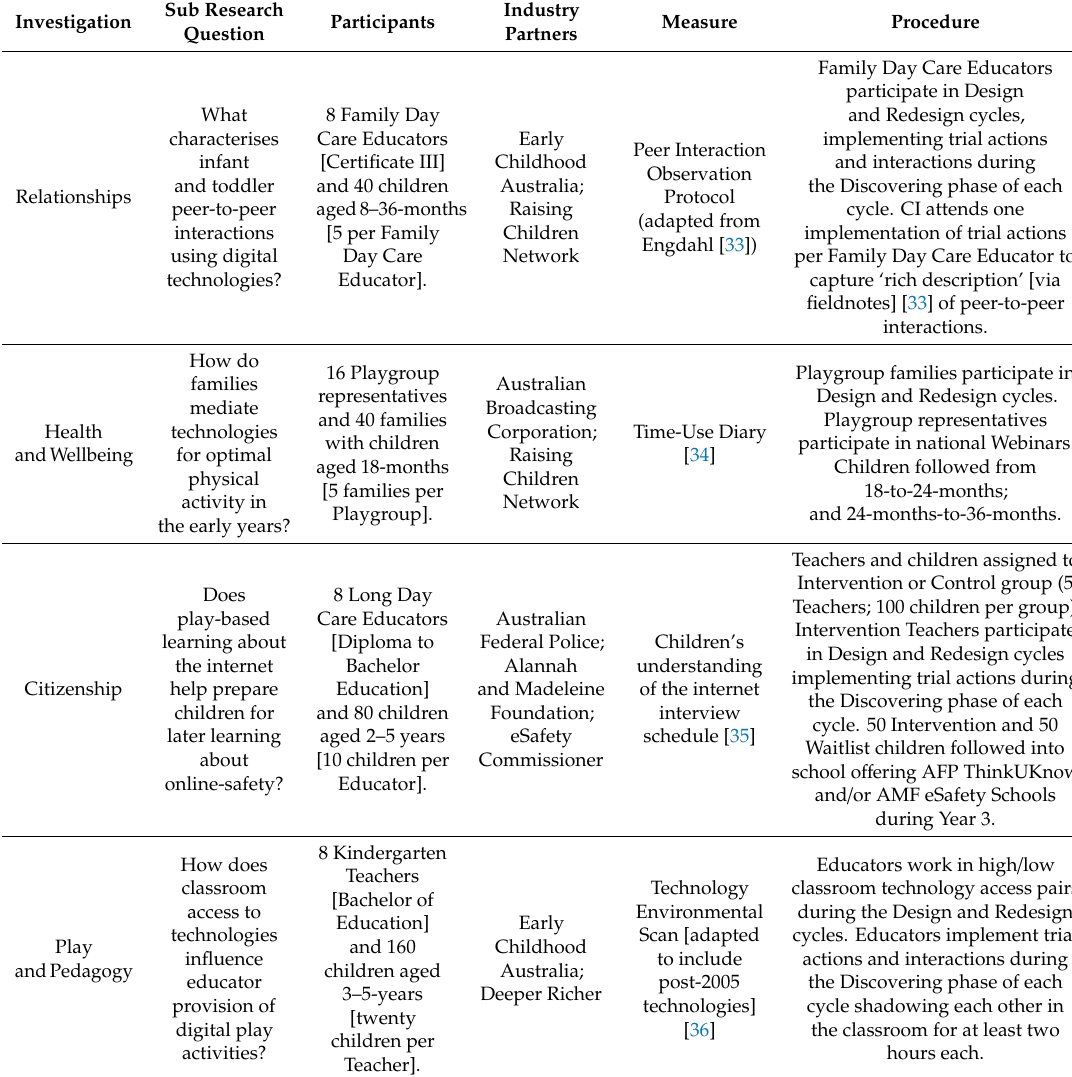
Table 1. Four investigations relative to design and Redesign cycles.